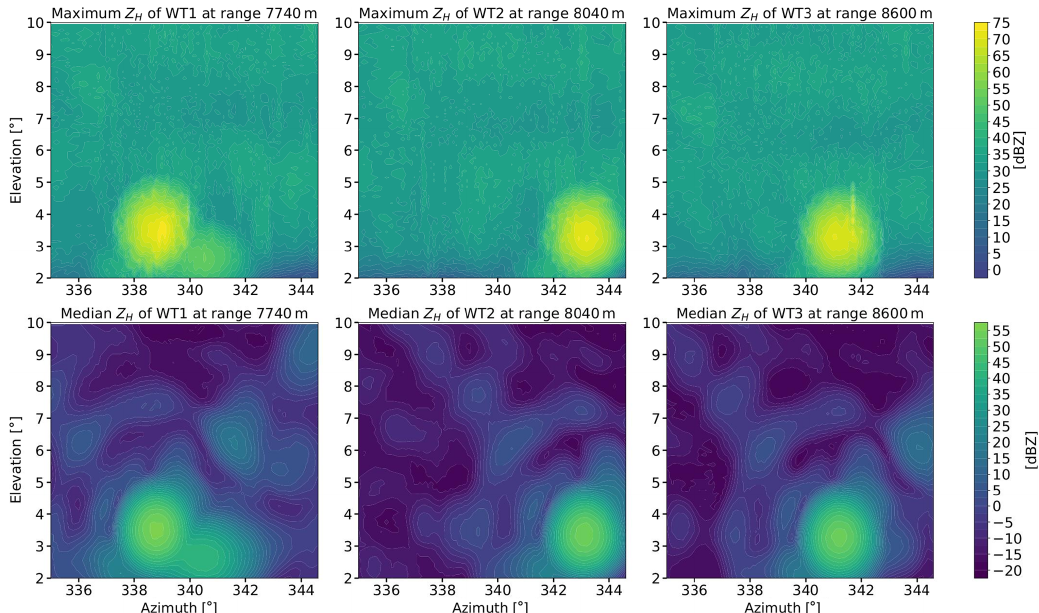
Figure 7. Maximum (first row) and median (second row) fixed-range statistics from RHI radar scan data of horizontal reflectivity Z H for all three observed wind turbines during the entire measurement campaign in March 2019. The first column shows the results for WT1 (range: 7740m), the second column the results for WT2 (range: 8040m) and the third column the results for WT3 (range: 8600m). The elevation angles go up to 10 ◦ , and the azimuth range is 9 . 6 ◦ (see Table